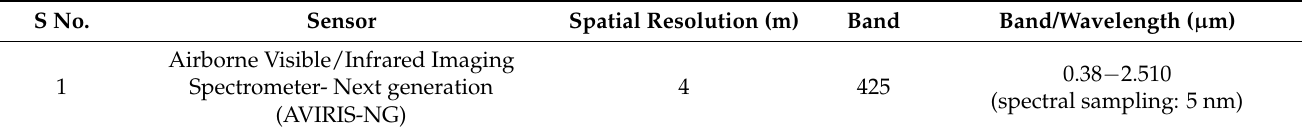
Table 1. Specification of AVIRIS-NG